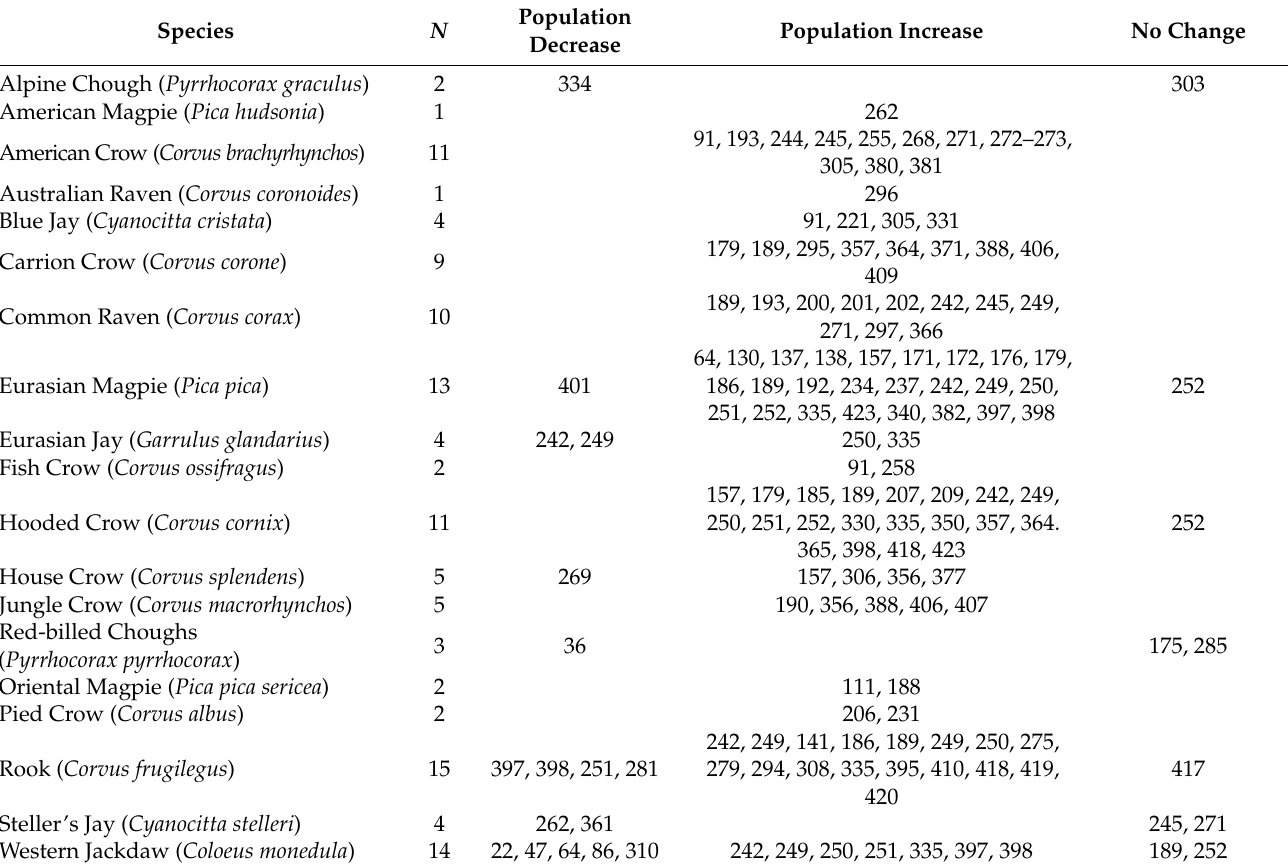
Table 1. Articles reporting positive, negative or no effects of urbanization on the abundance/density of populations in different corvid species (total n = 92). The reference numbers in the table refers to the individual publication numbers given in Table S2.